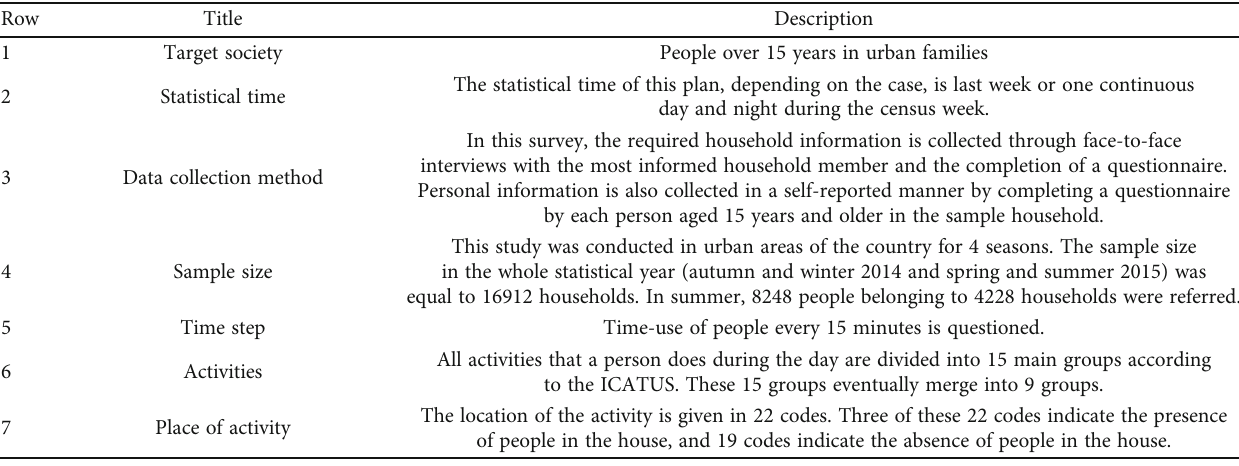
Table 5: Characteristics of the time-use survey data in this